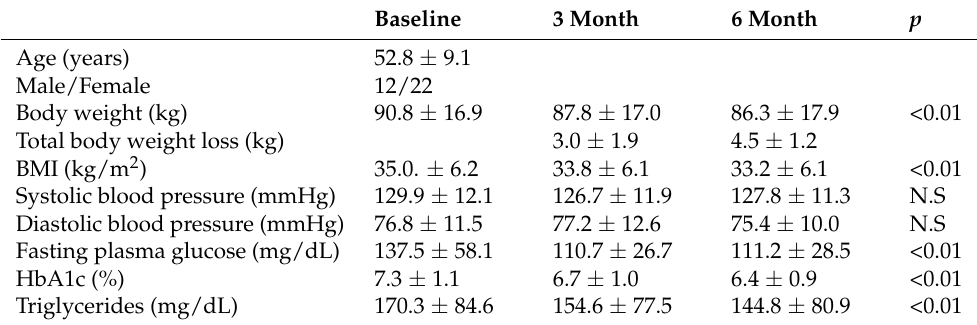
Table 1. Basal and time-course changes in body weight and plasma metabolic